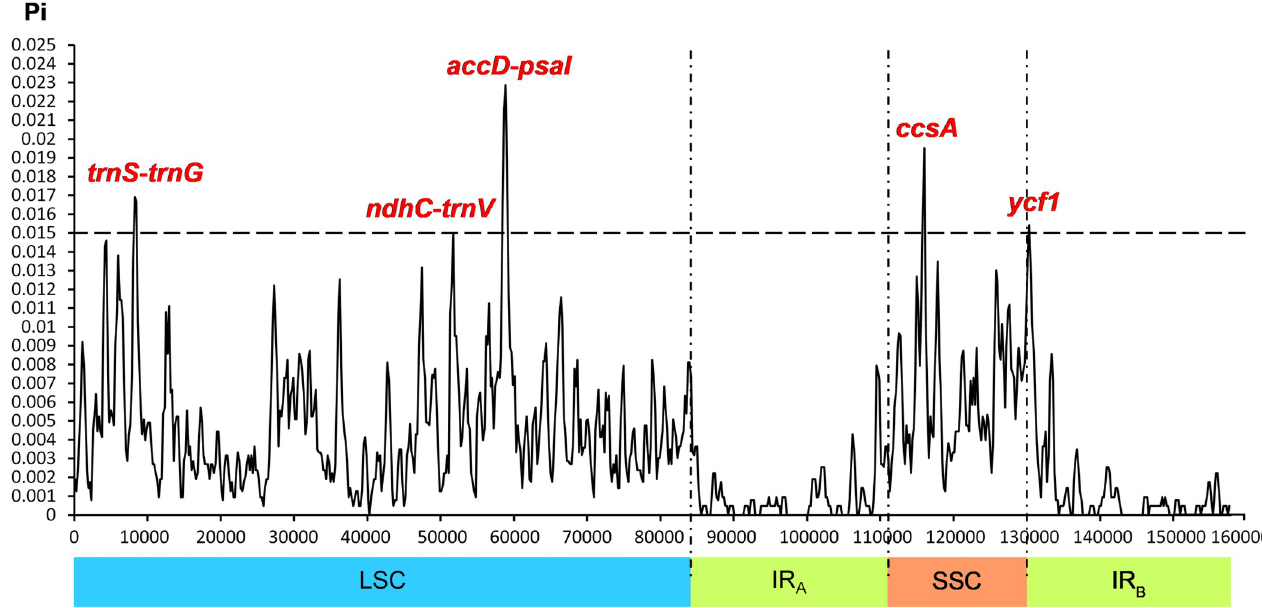
Fig 9. Complete cpDNA genome nucleotide diversity for the seven Asparagus species. X-axis: window midpoint; Y-axis: nucleotide diversity value (Pi) for each window. Divergence hotspots (Pi > 0.015) are labelled in red above the corresponding position.